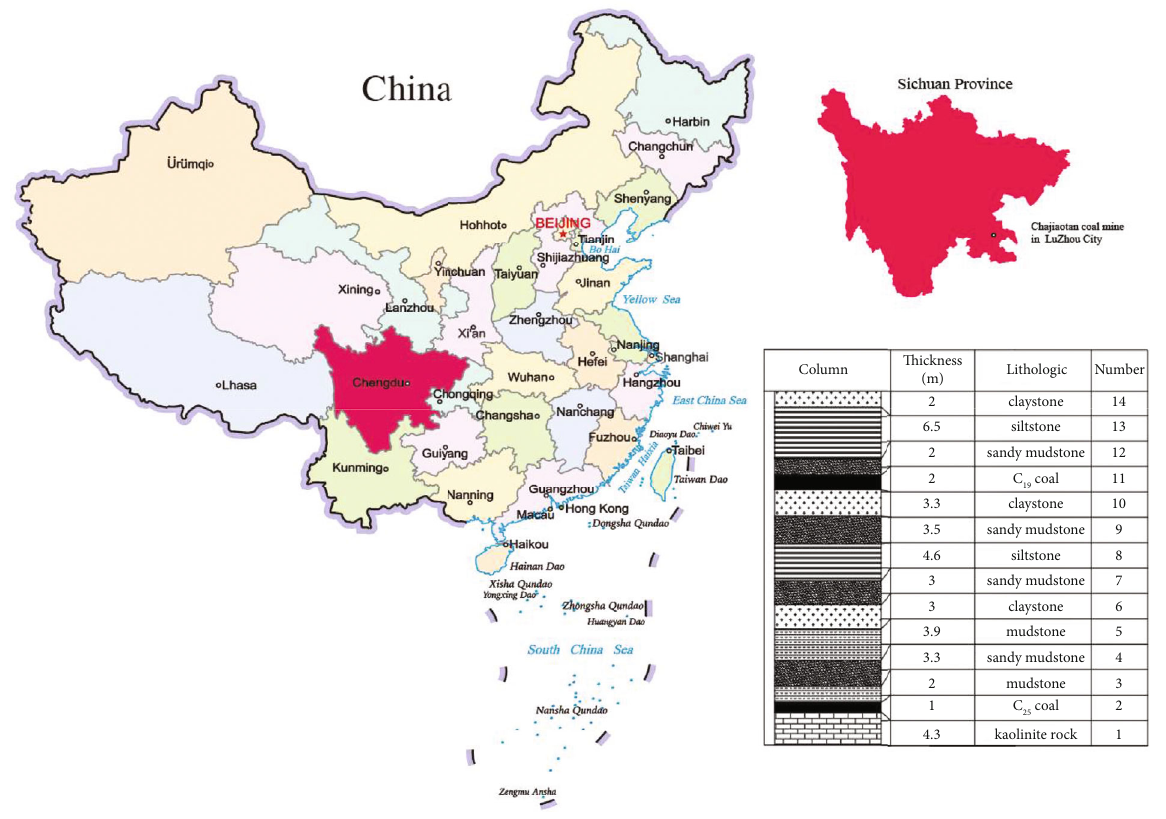
Figure 1: Geographical position and lithology columnar of Chajiaotan mine. Table 1: Classi fi cation